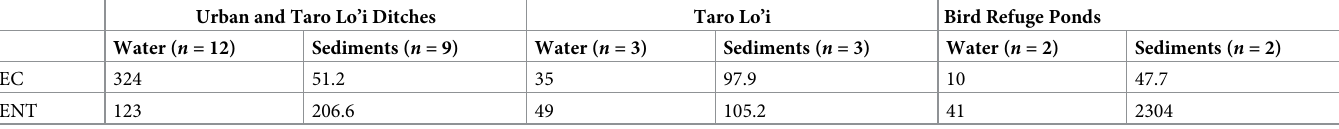
Table 5. Concentration of EC and ENT in potential source water and sediment samples. Units of the reported concentration in water are MPN/100 mL and in sedi- ments are MPN/g. The sample sizes are small for some sample types. Urban and Taro Lo’i